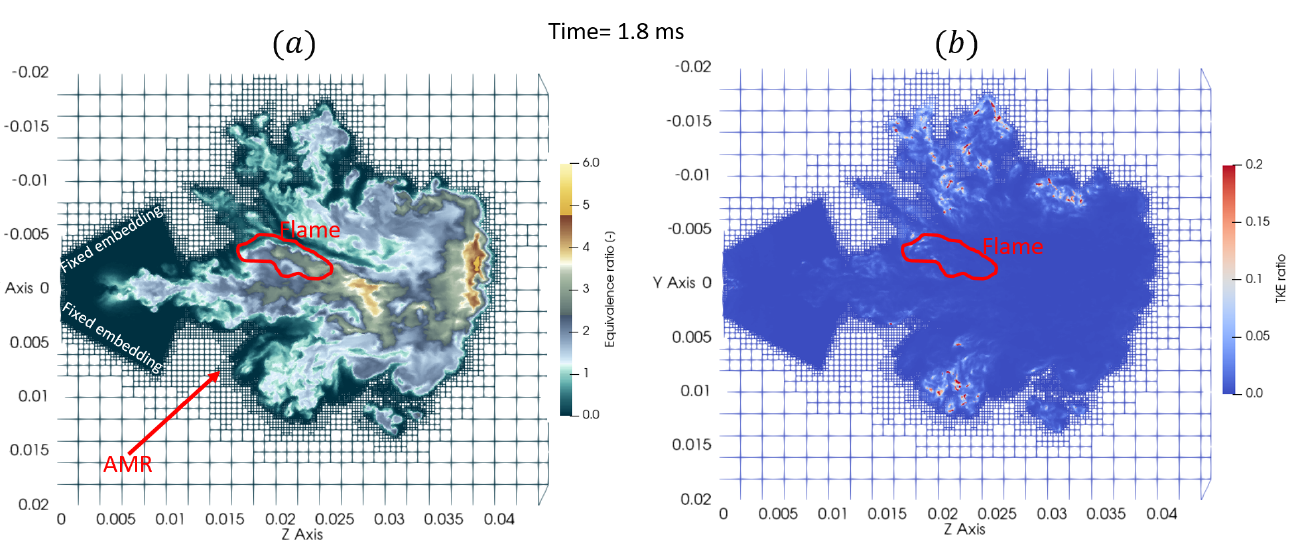
Figure 2. Slices of equivalence ratio ( a ) and TKE ratio ( b ) showing the grid layout at 1.8 ms (0.28 ms after ignition and 0.64 ms after the end of injection). The grid resolution in the AMR and in the fixed embedding region is 62.5 µ m. The injector is located at (Z = 0; Y = 0).